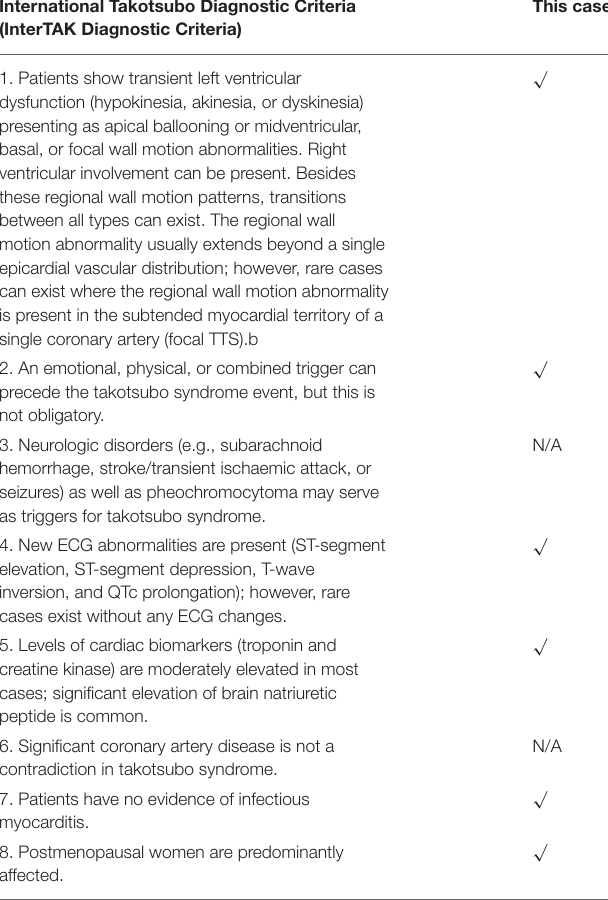
TABLE 1 | InterTAK Diagnostic Criteria for the case.